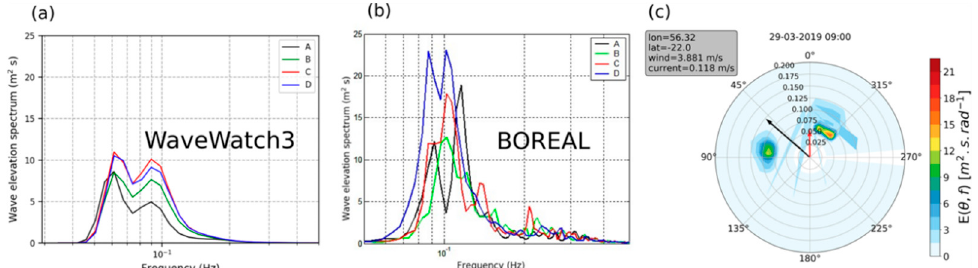
Figure 20. ( a ) Spectral density function of wave height simulated with WWW3 for legs A, B, C, and D. ( b ) Spectral density function of wave height from BOREAL UAS observations for legs A, B, C, and D. ( c ) Corresponding azimuth plot to wave elevation spectrum for leg A. The black (resp. red) arrow represents the wind direction (resp. current direction), and the scatter color are the wave crests. The length of the arrows has been scaled by 2.